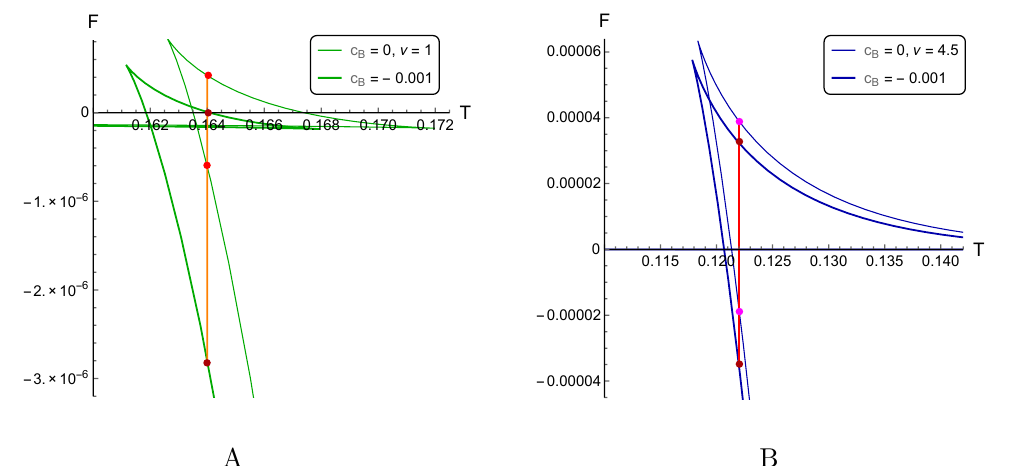
Figure 8 . Free energy difference ∆ F ( T ) for c B = 0 and c B = − 0 . 001 , ν = 1 (A) and ν = 4 . 5 (B); c = 0 . 227 , µ = 0 . 03 and T = 0 . 164 . Free energy difference and T are in units of GeV. where authors have found the bounced configurations interpolating between the vacua